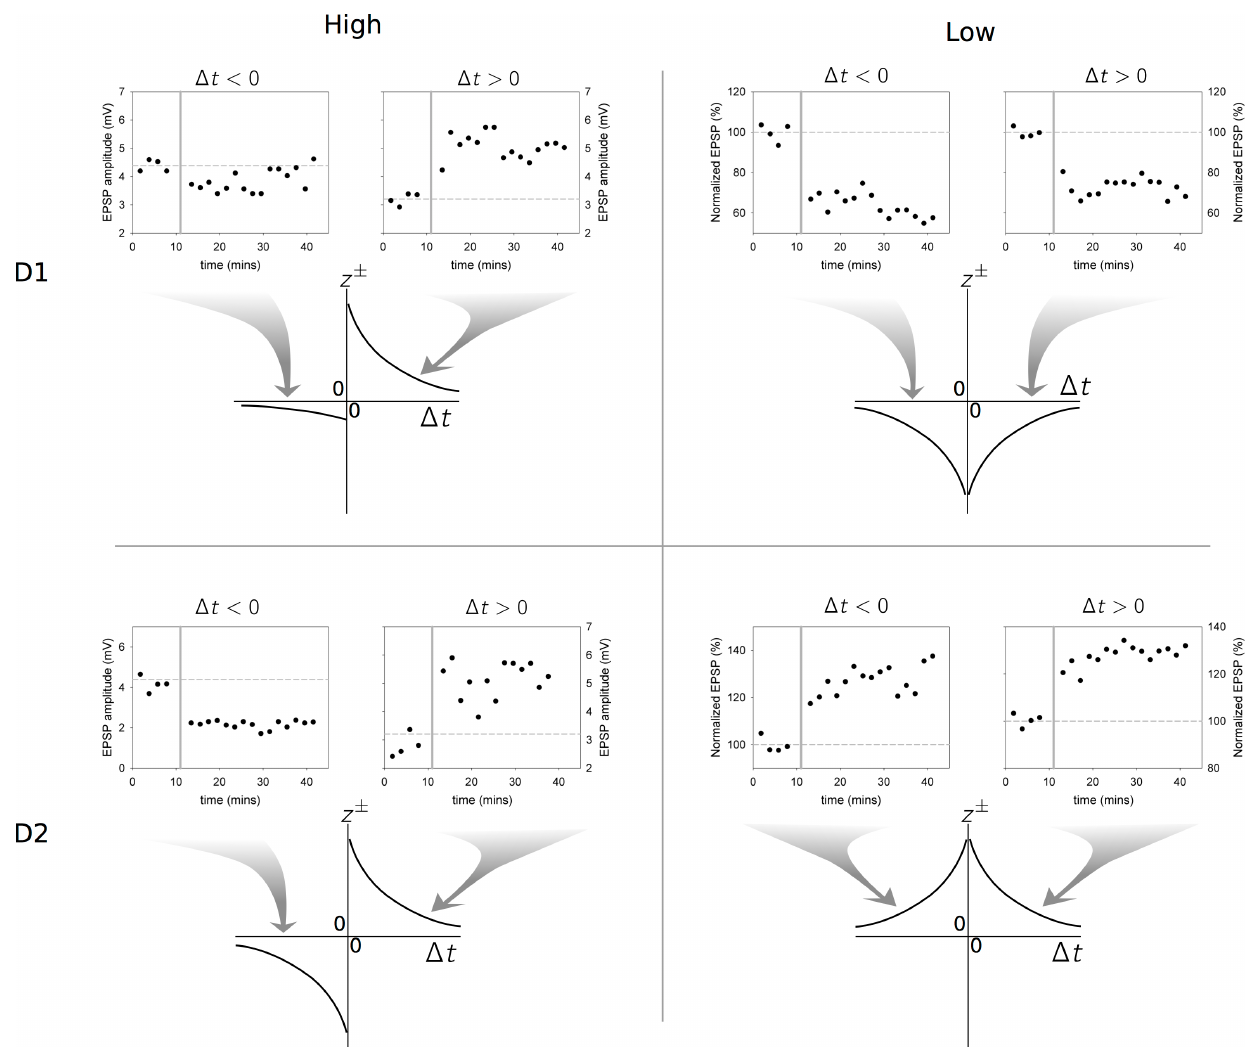
Figure 4. Deriving STDP functions from the in vitro data in [17] . Each row of the four panels pertains to an MSN type (D1, D2), each column to a dopamine level (‘‘high’’ or dopamine present, and ‘‘low,’’ or dopamine depleted). Thus, the top left panel shows data for MSNs expressing D1 receptors from slices with dopamine present. In each panel, the top right hand plot shows the EPSP amplitude against time under protocols designed to induce Hebbian learning, and in which the postsynaptic spikes follow their pre-synaptic counterparts (‘‘positive timing,’’ D t ~ t post { t pre w 0 ). Plasticity induction occurred during the period indicated by the reference line at 10 mins. The top left hand plot in each panel shows corresponding results for negative timing, D t v 0 . The resulting STDP functions ( z z ( D t ) for D t w 0 and z { ( D t ) for D t v 0 ) are shown in the cartoon diagrams, and the relation between data and function is indicated by the shaded arrows. Note that some of the vertical axes on the data plots show normalised EPSP amplitude as a percentage.